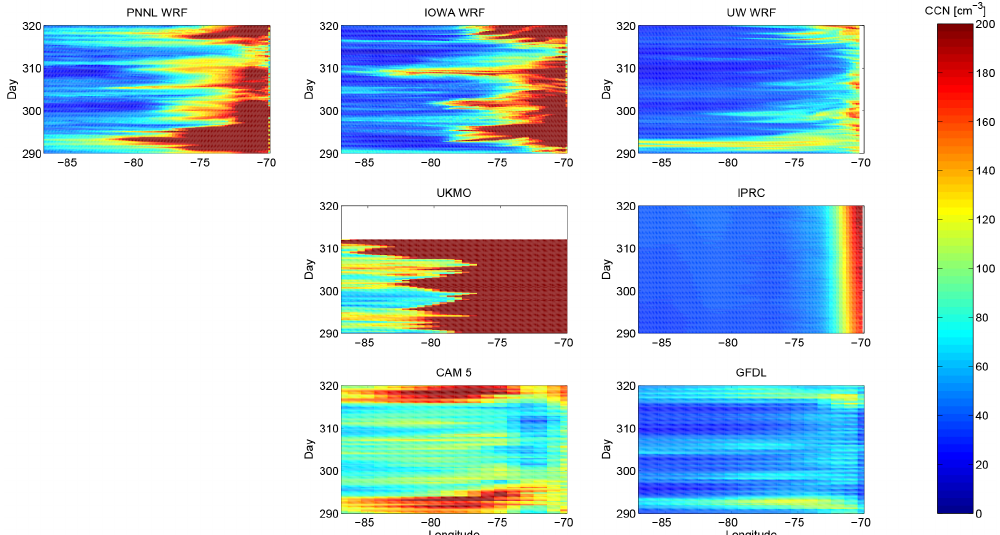
Figure 12. Hovmöller diagrams of CCN at 0.1% supersaturation at 150m height along 20 ◦ S. CCN concentrations are given in cubic